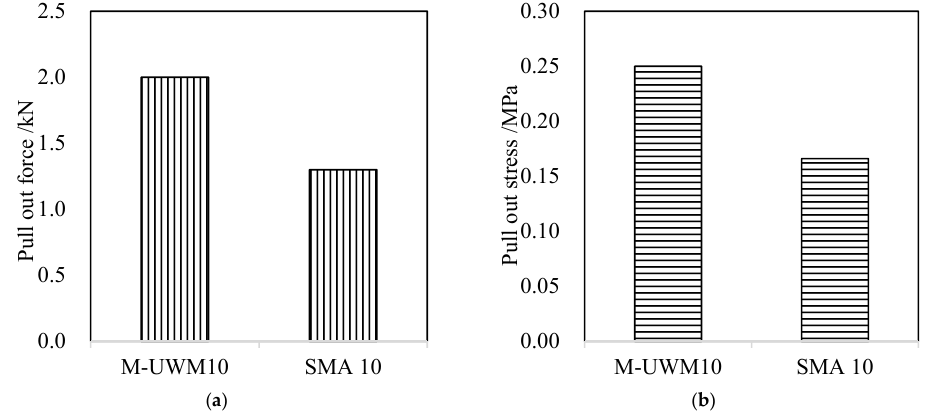
Figure 15. Pull out test results: ( a ) pull out force; ( b ) pull out stress.